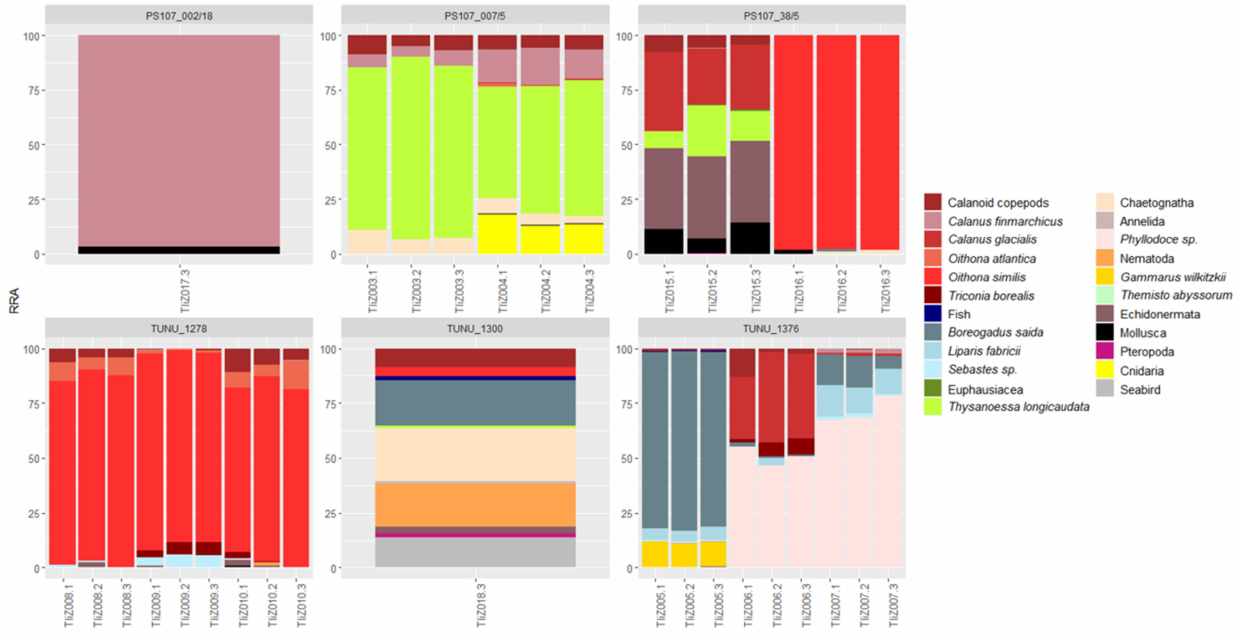
Figure A1. Prey spectrum found in the stomachs of T. libellula at different stations, including the PCR replicates per station. Number of reads are given in relative read abundances (RA); colors indicate different prey items; names of x-axis indicate sample IDs. Prey items contributing less than